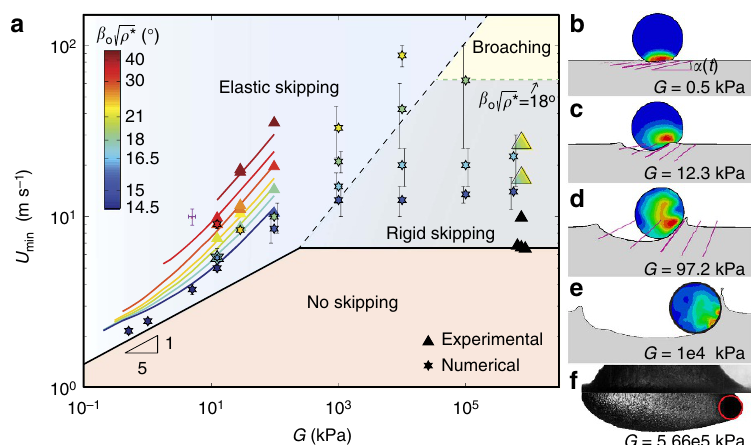
Figure 4 | The effect of material stiffness on skipping behaviour. ( a ) Below a threshold stiffness ( G E 10 3 (cid:2) 10 4 kPa, depending on b o ), the elastic response of the sphere affects skipping. In this elastic regime, the minimum speed required to skip U min decreases monotonically with decreasing shear modulus G , as shown by both experimental and numerical results (triangle and star markers, respectively). In the limit of small G we expect U min p G 1/5 , which is confirmed by the numerics. As stiffness increases above G E 10kPa, U min deviates from this relation as larger G augments the rate of change of a , thereby reducing the upward vertical force component. Our analytical model also captures this change in behaviour (solid coloured lines). For shallow impact angles, U min becomes insensitive to shear modulus for G 4 E 10 3 kPa, indicating that rigid sphere skipping behaviour is recovered. The transition between the elastic and rigid skipping regime occurs at larger G as b o increases. In the rigid skipping regime, U min is very sensitive to b o (also evident in Supplementary Fig. 1). The lower bound of the p rigid skipping regime is inferred from the dark triangle symbols, which occur for experiments with b o ffiffiffiffiffi r ? o 14 : 5 (cid:2) . The coloured triangle markers at p . The upper bound on the rigid regime G ¼ 5.66 (cid:3) 10 5 kPa result from experiments where the colour gradient on the marker indicates the uncertainty in b o ffiffiffiffiffi r ? p p corresponds to b o ffiffiffiffiffi r ? 4 18 (cid:2) spheres may broach (that is, completely immerse before exiting), but not skip 8 . ( b – ¼ 18 (cid:2) ; prior literature suggests that for b o ffiffiffiffiffi r ? d ) Numerical simulations show that increasing G results in a larger rate of change of a (purple lines) in the elastic skipping regime. Each image shown is 6ms after impact and the interval between a measurements is 2ms. ( e ) As shear modulus increases into the rigid regime, the sphere deformation is negligible (black p outline is undeformed sphere contour). ( f ) We have observed broaching for rigid spheres impacting with b o ffiffiffiffiffi r ? 4 18 (cid:2) . Sphere properties for data in ( a ): rigid sphere experiments, R ¼ 25.8mm, r * ¼ 0.959, G ¼ 5.66 (cid:3) 10 5 kPa; all other data markers, R ¼ 26.2mm, r * ¼ 0.937 for G r 12.3kPa and r * ¼ 1.03 for G 4 12.3kPa. The purple error bars are characteristic for experimental data. The numerical error bars represent ± 1/2 of the difference in U o between the skipping and non-skipping cases used to compute U min ; error bars are offset for